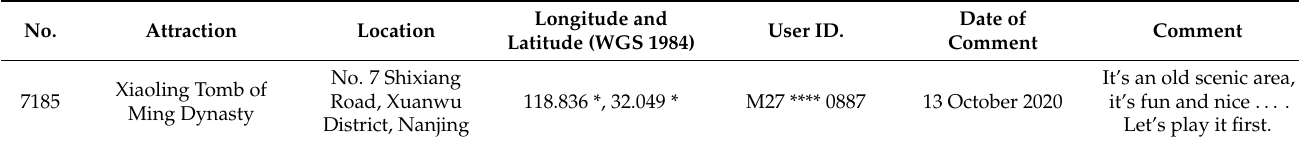
Table 1. The example of the research sample from the Ctrip